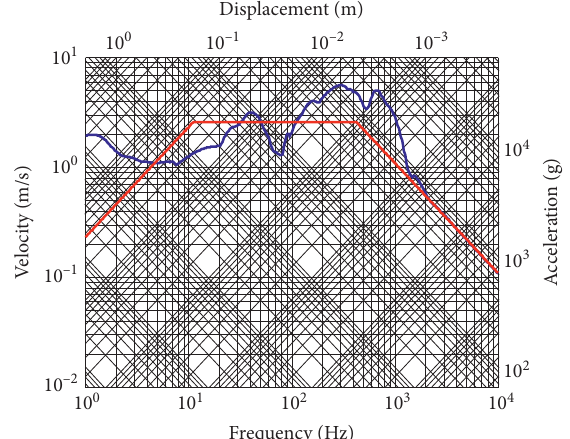
Figure 14: Shock response spectrum and design response